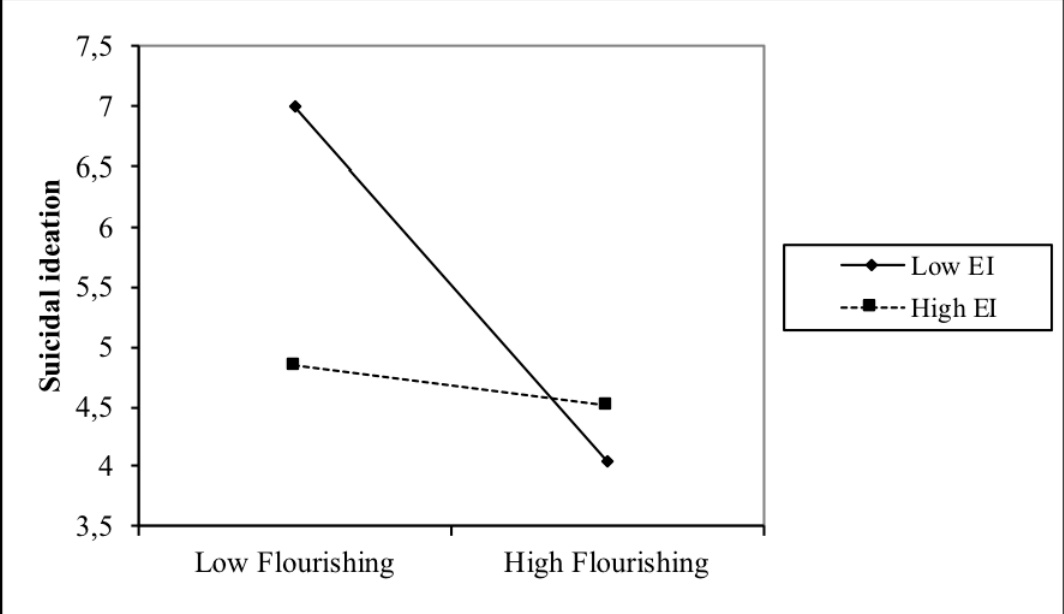
Figure 3. Interaction between EI and flourishing with regards to suicidal ideation.